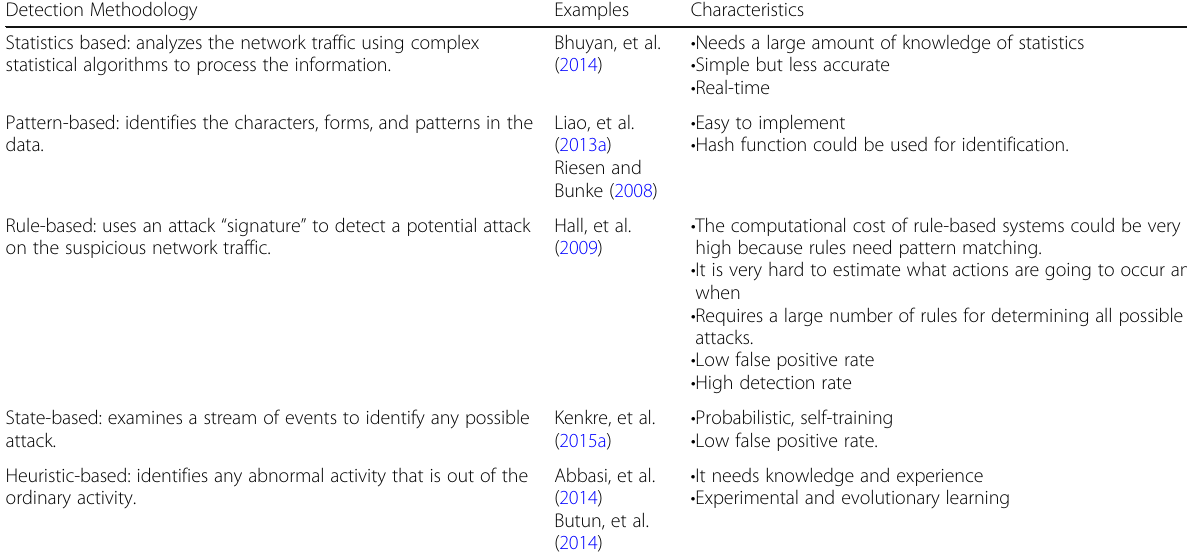
Table 3 Detection methodology characteristics for intrusion-detection systems Detection Methodology Examples